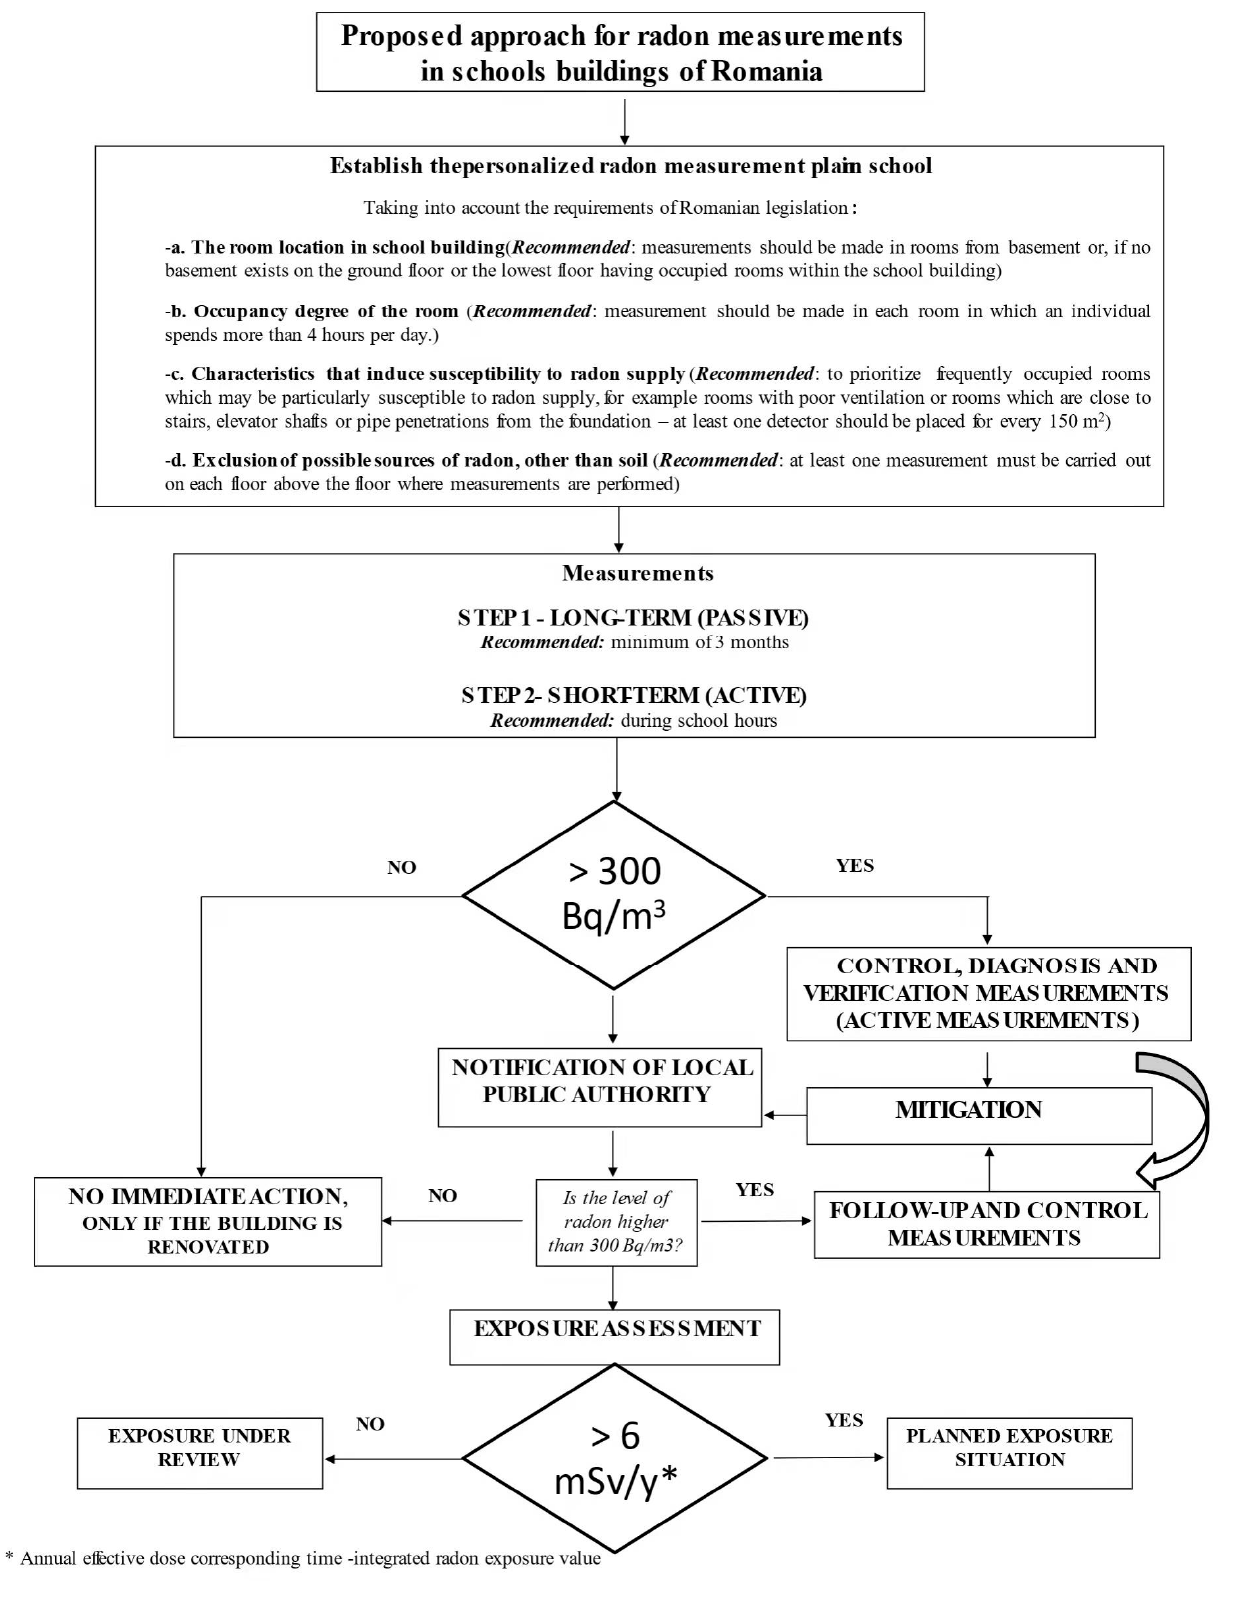
Figure 3. The proposed approach for radon measurements in Romanian schools, according to the international recommendations.